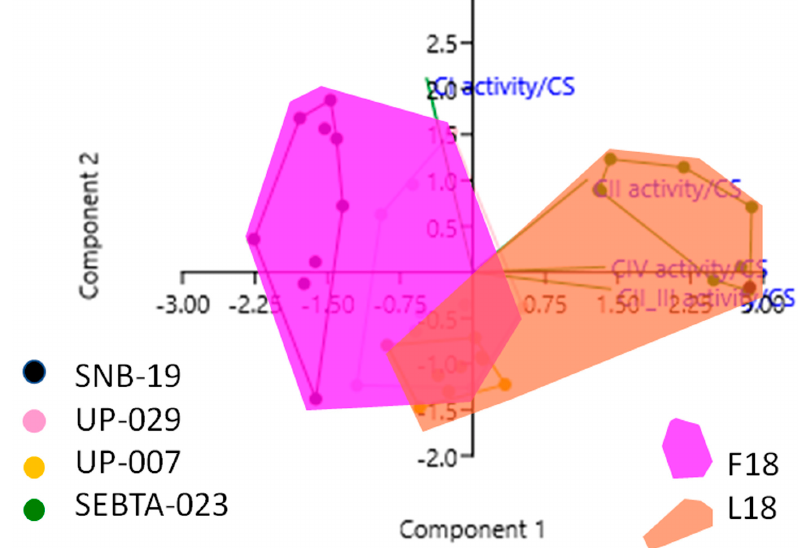
Figure 2. Principal Component Analysis (PCA) plot showing the multivariate variation among four cell lines examined in terms of their complex I, II, II_III and IV activities (expressed relative to citrate synthase (CS) activity in each case). Vectors (green lines) indicate the direction and power of each complex activity dataset relative to the overall distribution. Coloured dots delineate the four cell lines, while the pink and the orange shaded areas highlight the two groups identified in this study, that correlate with the F18L-carriers and non-carriers, respectively. The first two principal axes shown explained 83% of the variance observed among the data.